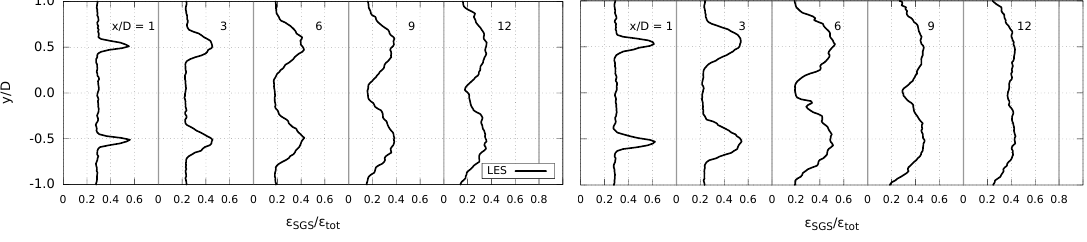
Figure 11. Vertical profiles of ε / ε tot behind the disk C T = 0.42 ( left ) and C T = 0.62 ( right ), Ti3 case. SGS